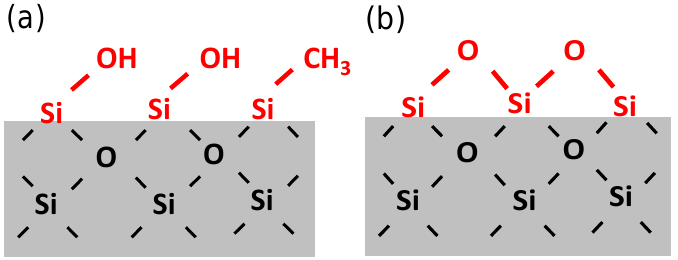
surface treated by ( a ) HP dipping; 2 surface will mainly 2 ). While for the 3 2